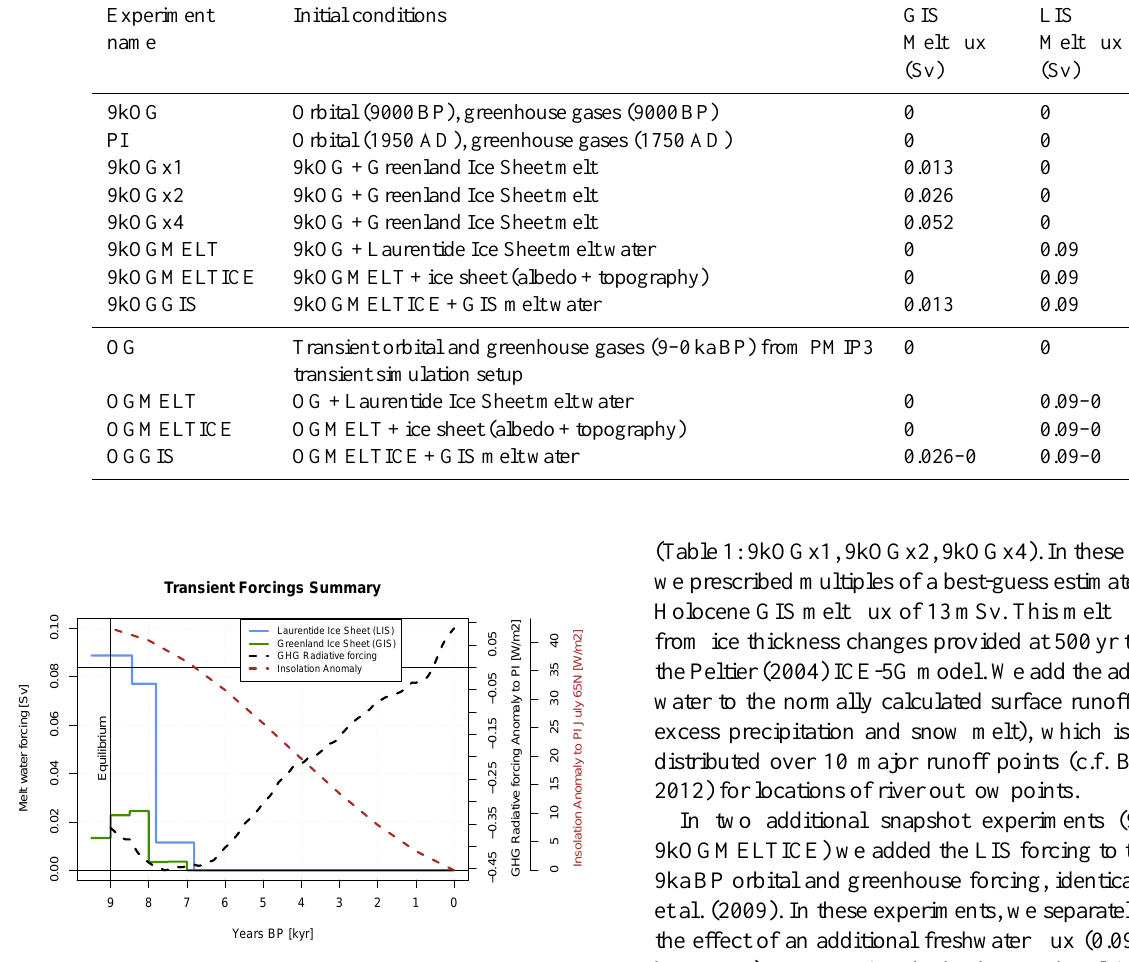
Fig. 1. Equilibrium and transient forcings applied in simulations. Shown are melt water forcings and orbital and greenhouse gas changes compared to the pre-industrial era. Topography changes of the LIS are not shown. Blue is the total LIS melt water flux ap- plied in simulation OGMELT, OGMELTICE and OGGIS (left axis). The green curve denotes the calculated GIS melt water from Peltier (2004) prescribed in OGGIS (left axis). Black gives the radiative forcing due to greenhouse gas concentrations as anomaly to the pre-industrial era and the red curve gives the July 65 ◦ N insolation anomaly after Berger and Loutre (1991) (right axis). Greenhouse gas radiative forcing is calculated using IPCC (2001) formulation.